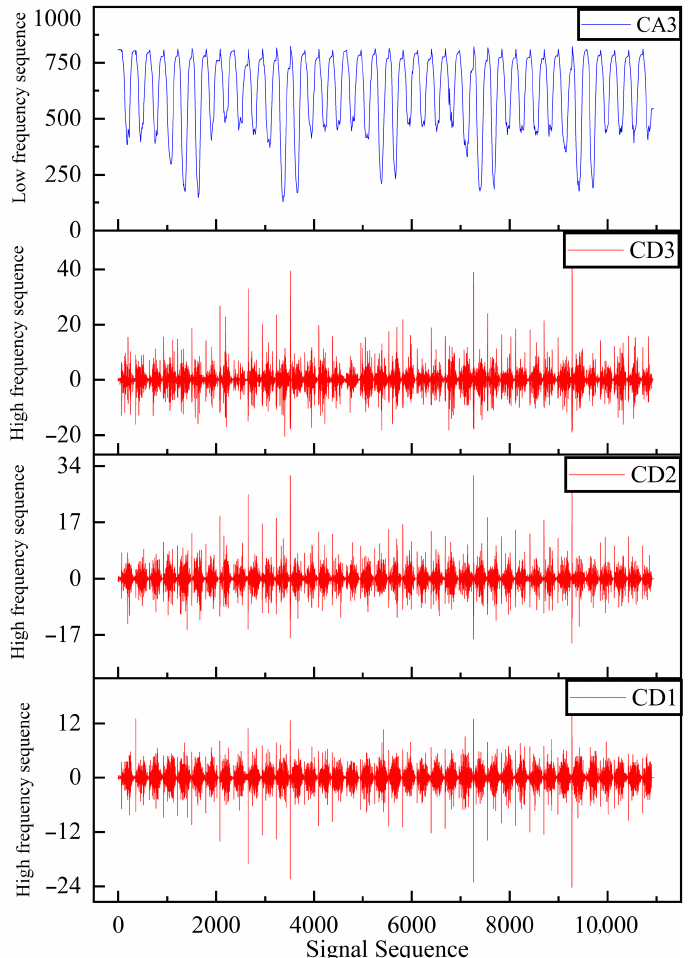
Figure 6. db3 wavelet decomposition diagram.